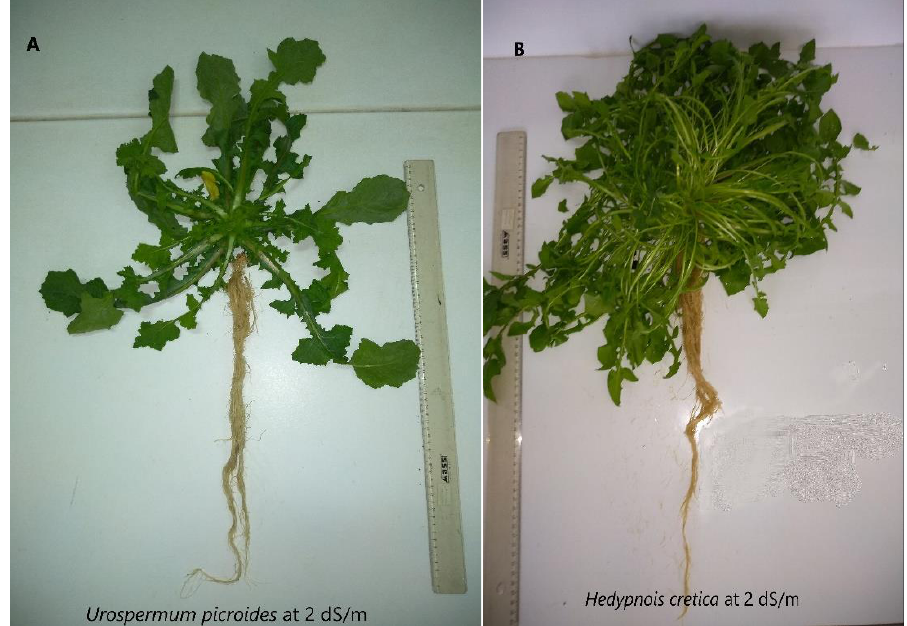
Figure 1. Plants of Urospermum picroides ( A ) and Hedypnois cretica ( B ) grown at 2 dS m −1 .